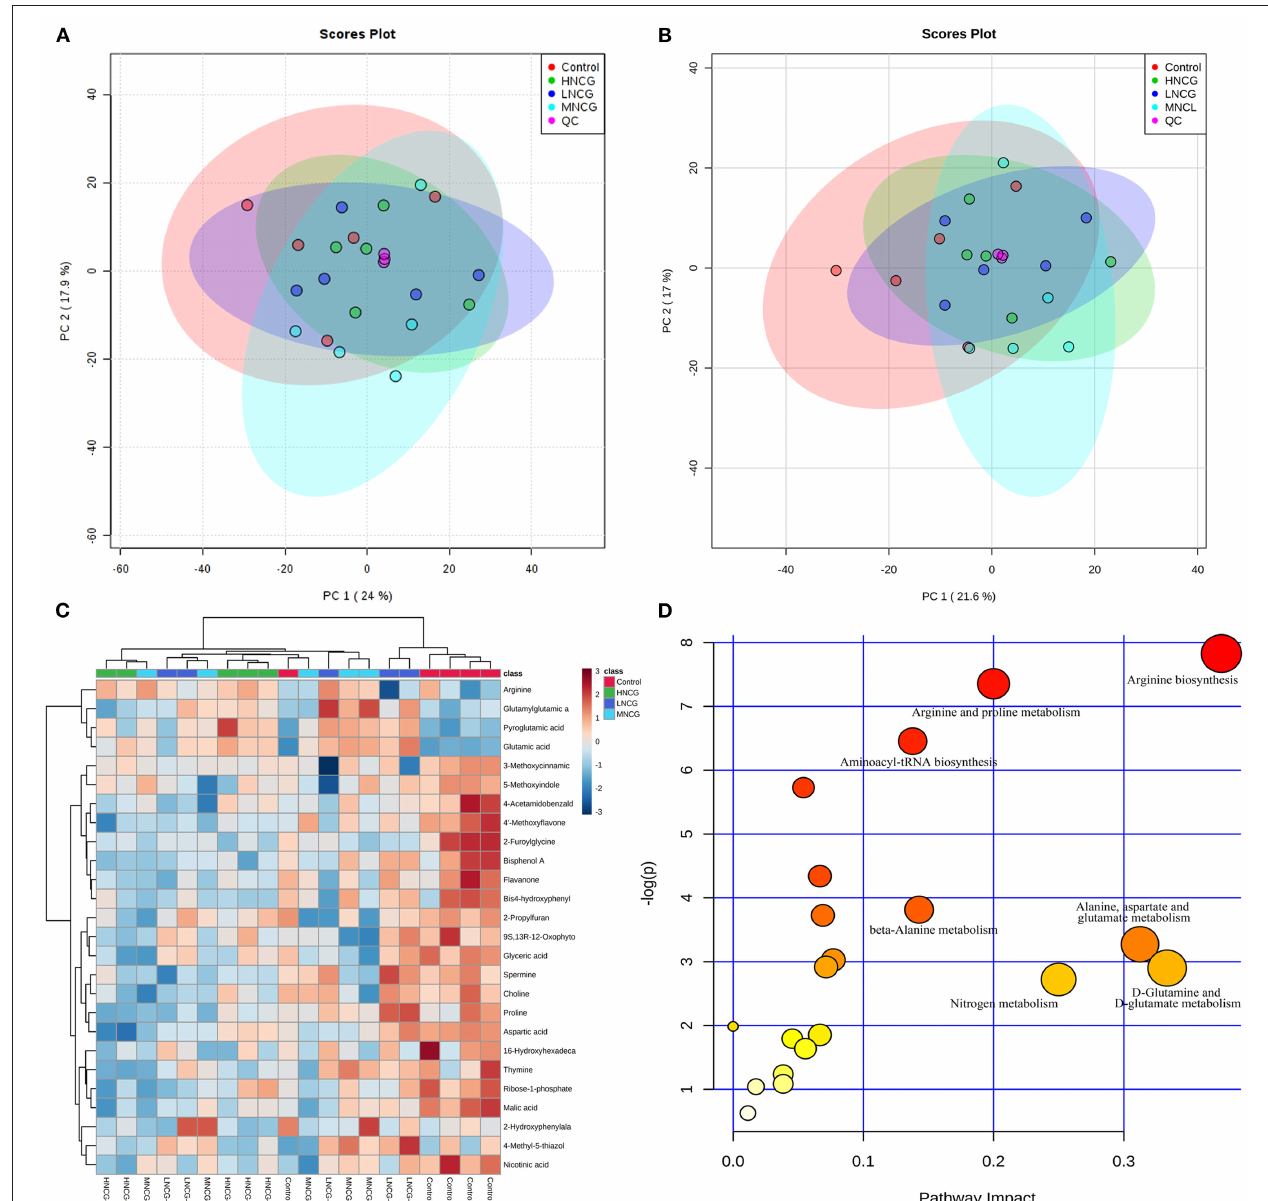
FIGURE 3 | Effects of NCG supplementation on metabolomic profile in ruminal fluid. NCG, N-carbamylglutamate; Control, without NCG supplementation; LNCG, NCG at 15 g/day per cow; MNCG, NCG at 20 g/day per cow; HNCG, NCG at 25 g/day per cow. (A,B) PCA score plots of the ruminal fluid from the control and NCG groups analyzed by UPLC-Q-TOF/MS analysis in positive (A) and negative modes (B) . PCA, principal component analysis; QC, quality control samples. (C) Hierarchical clustering heatmap of the identified metabolites. The relative intensity of the metabolites was indicated by the color of the heatmap. (D) Pathway analysis of the metabolites obtained from ruminal fluid in response to NCG